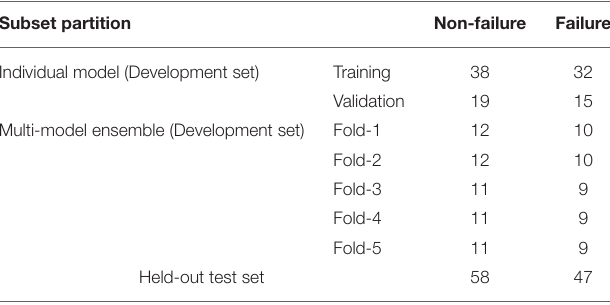
TABLE 1 | Number of cases used in the model development and